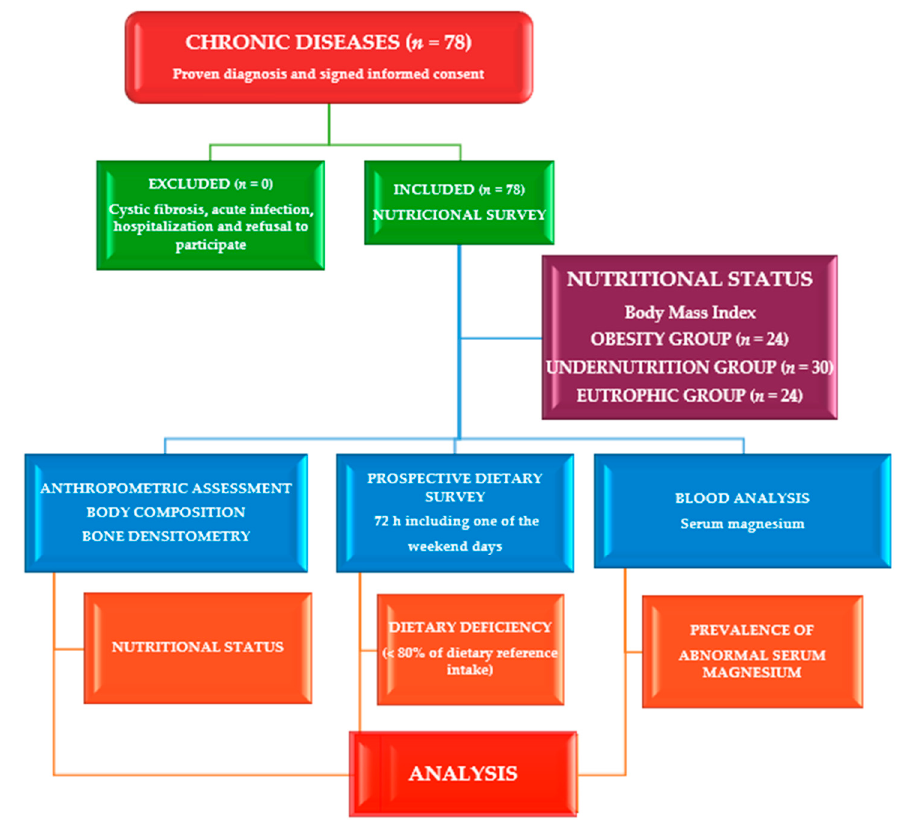
Figure 1. Flowchart of the study conducted on children and adolescents with chronic disease ( n = 78).